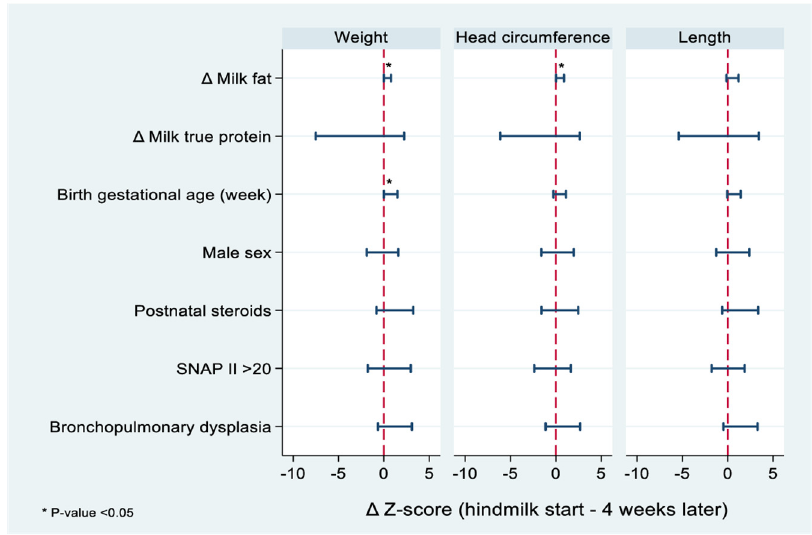
Figure 3. Multiple linear regression for associations between hindmilk fat content and anthropometric growth velocities in preterm infants. Δ Z − score is measured as a change in Z − score per every 1 g/dL difference in fat ( Δ fat) and true protein ( Δ true protein) between composite milk and hindmilk. The ∆ fat and ∆ true protein are based on a single analysis for composite milk and hindmilk.